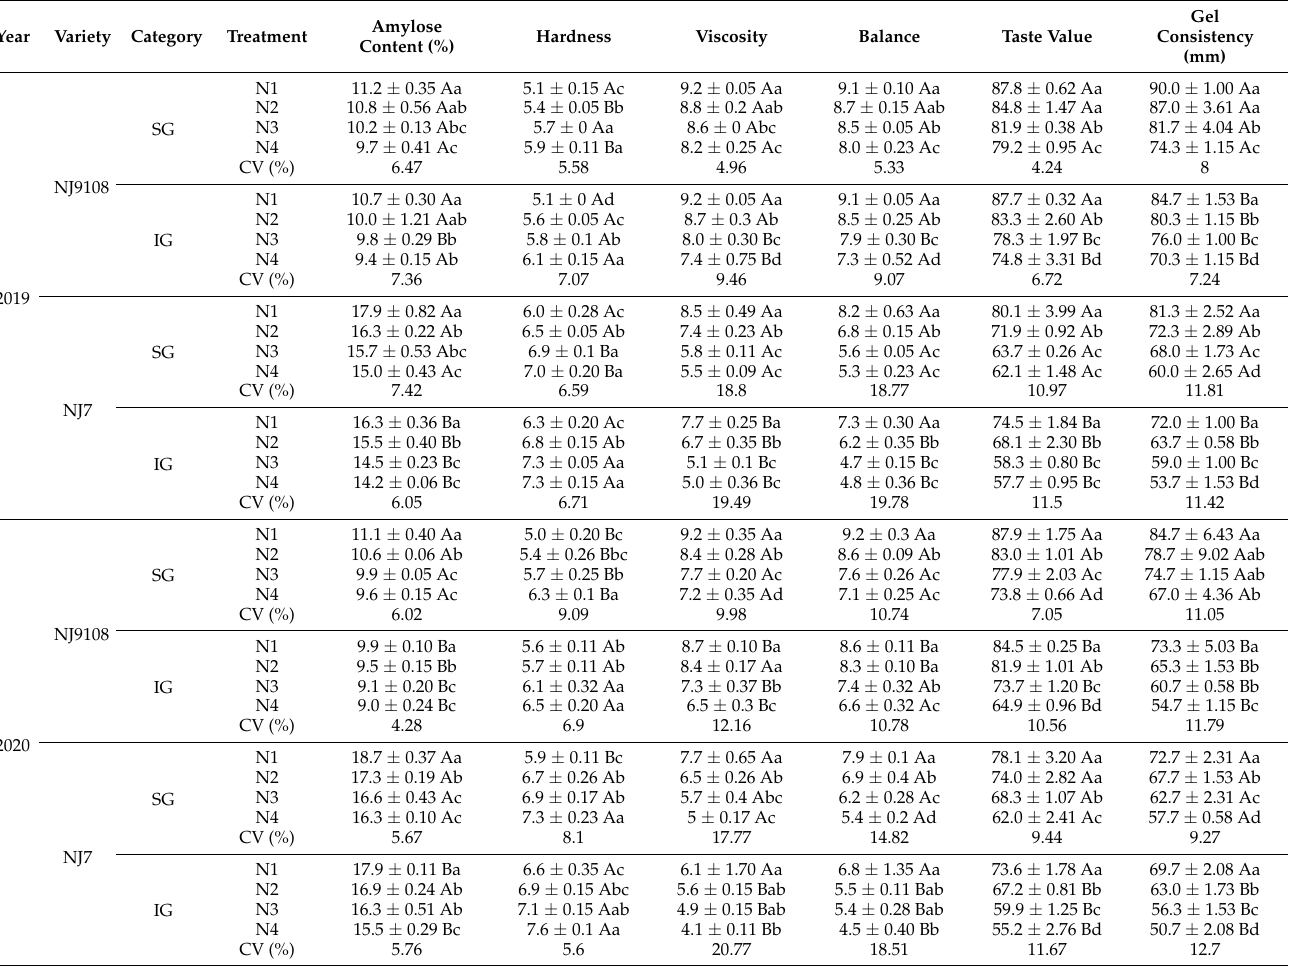
Table 4. Effects of nitrogen fertilizer levels on cooking and eating quality of strong and weak rice grains in 2019 and